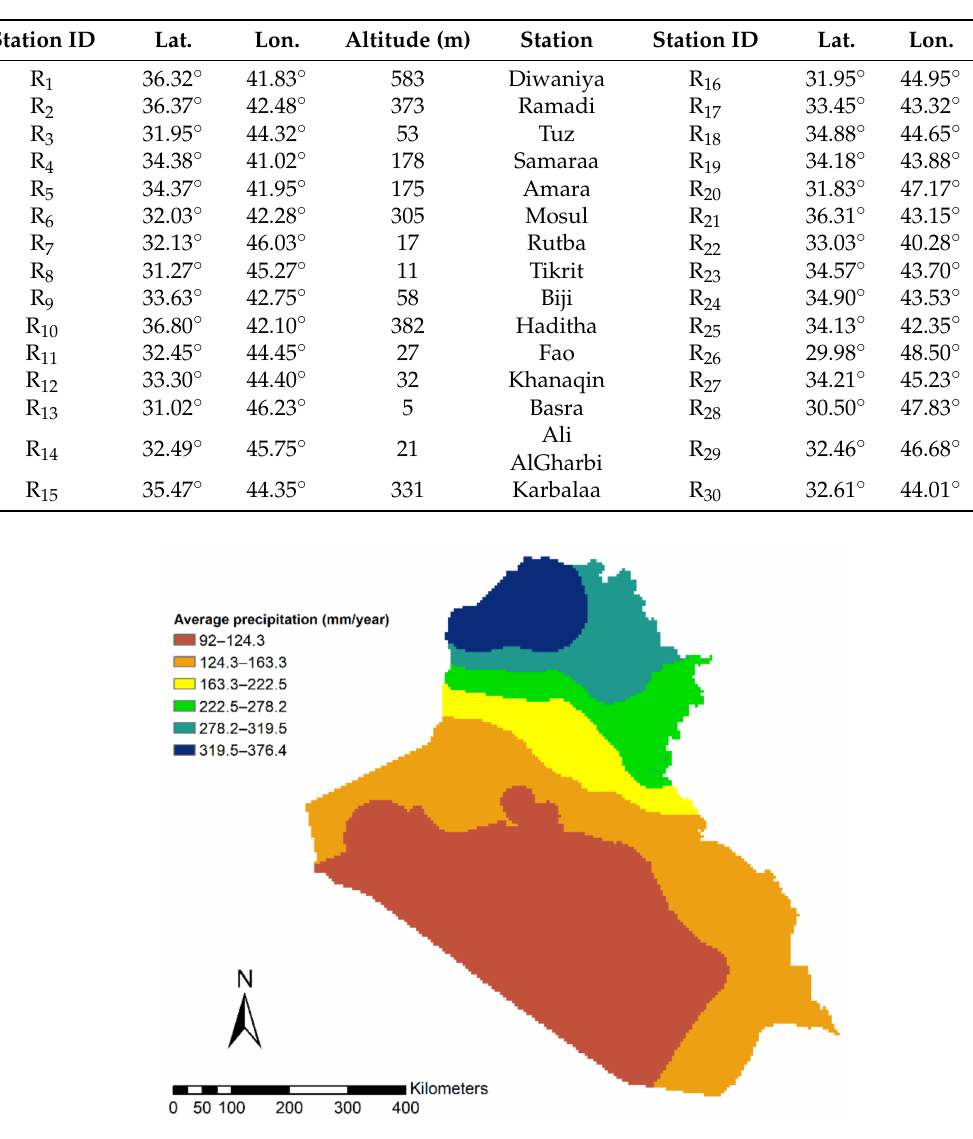
Figure 2. Average annual precipitation over Iraq from 1941 to